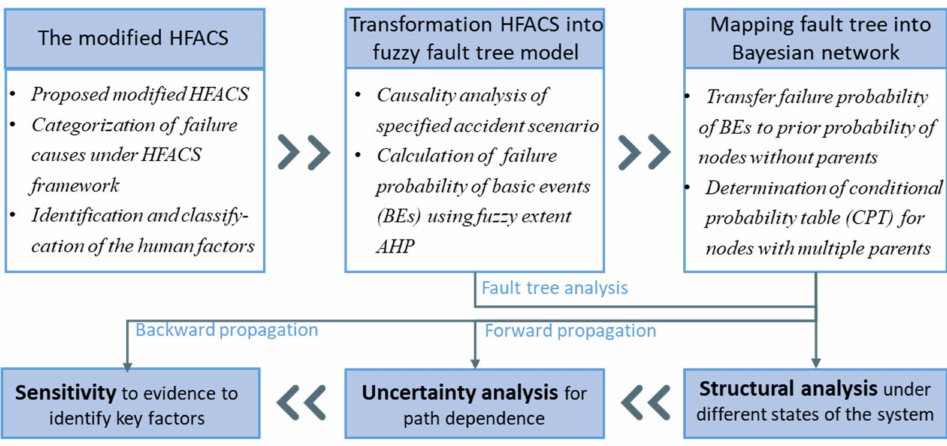
Figure 2. Overview of the proposed